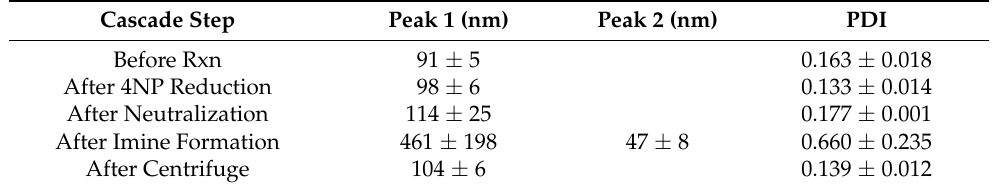
Table 3. DLS measurements of nanoreactor reaction solution throughout the one-pot reaction. ( n =